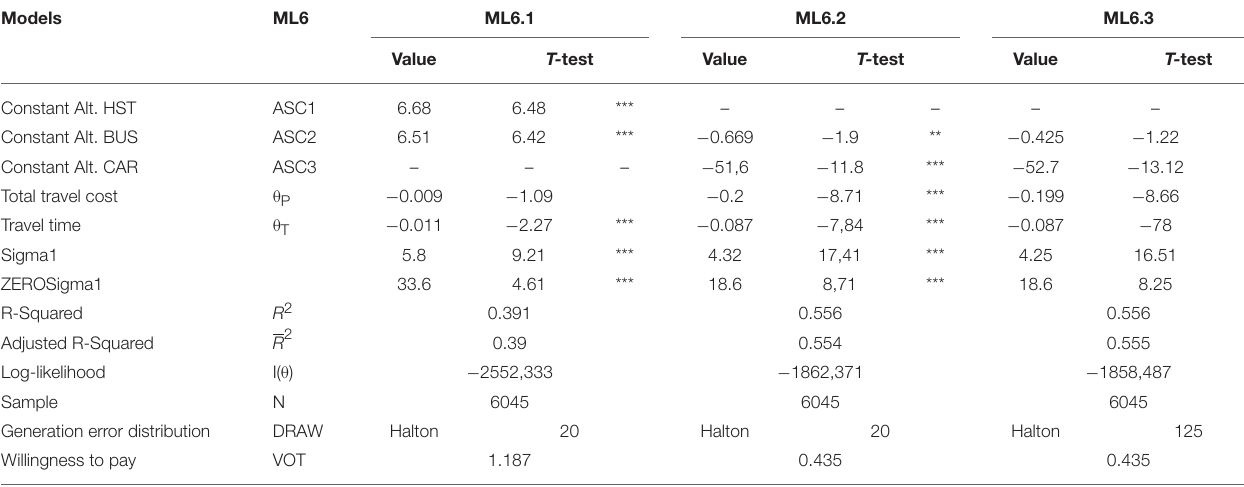
TABLE 6 | Results of ML models estimated with three alternatives, with panel effect and with scaled data.